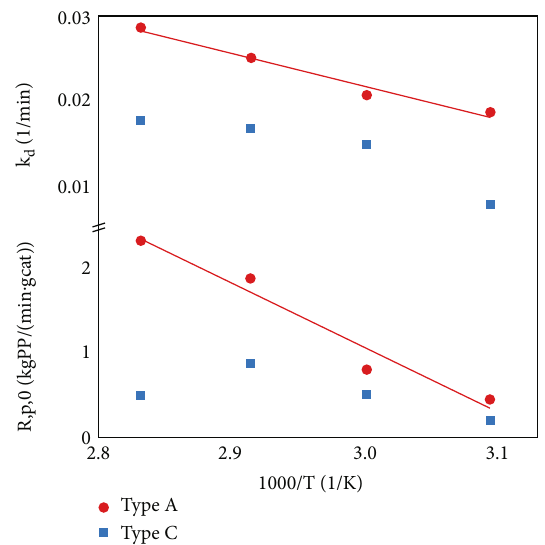
Figure 6: Arrhenius plot for the initial reaction rate and deactivation rate constant at di ff erent temperatures. Blue square: type A catalyst injection; red dot: type C catalyst injection; the partial pressure of hydrogen was